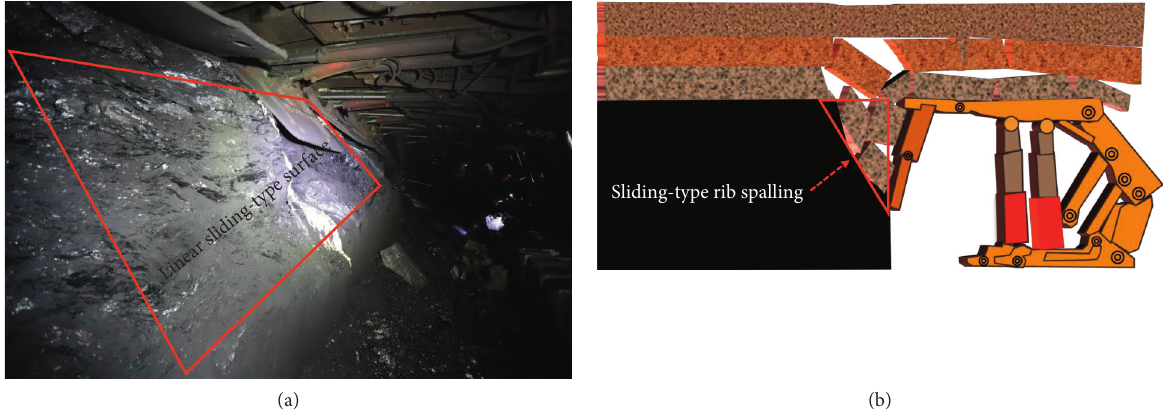
Figure 2: Rip spalling in 1508 Working Face. (a) Current status of rib spalling. (b) Sliding-type rib spalling.